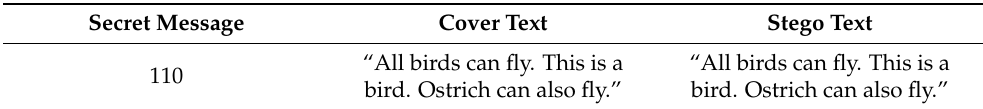
Table 4. Example of format-based text steganography (Data from [37]).